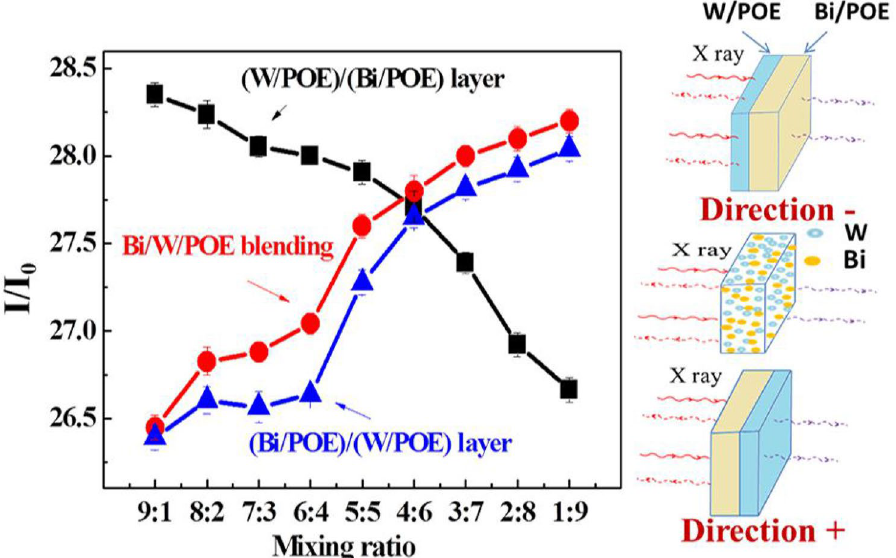
Figure 2. Dose ratio (I/I 0 ) of X-ray passed through the blending and layered composites, and its sketch was also shown on the right side to clearly indicate the incident direction of X ray and structural differences of layered composites with different layer thickness ratio. When the X-ray firstly interacted with layered tungsten/polymer composites, this direction was defined as “Direction−”. Conversely, this direction was defined as “Direction + ”.